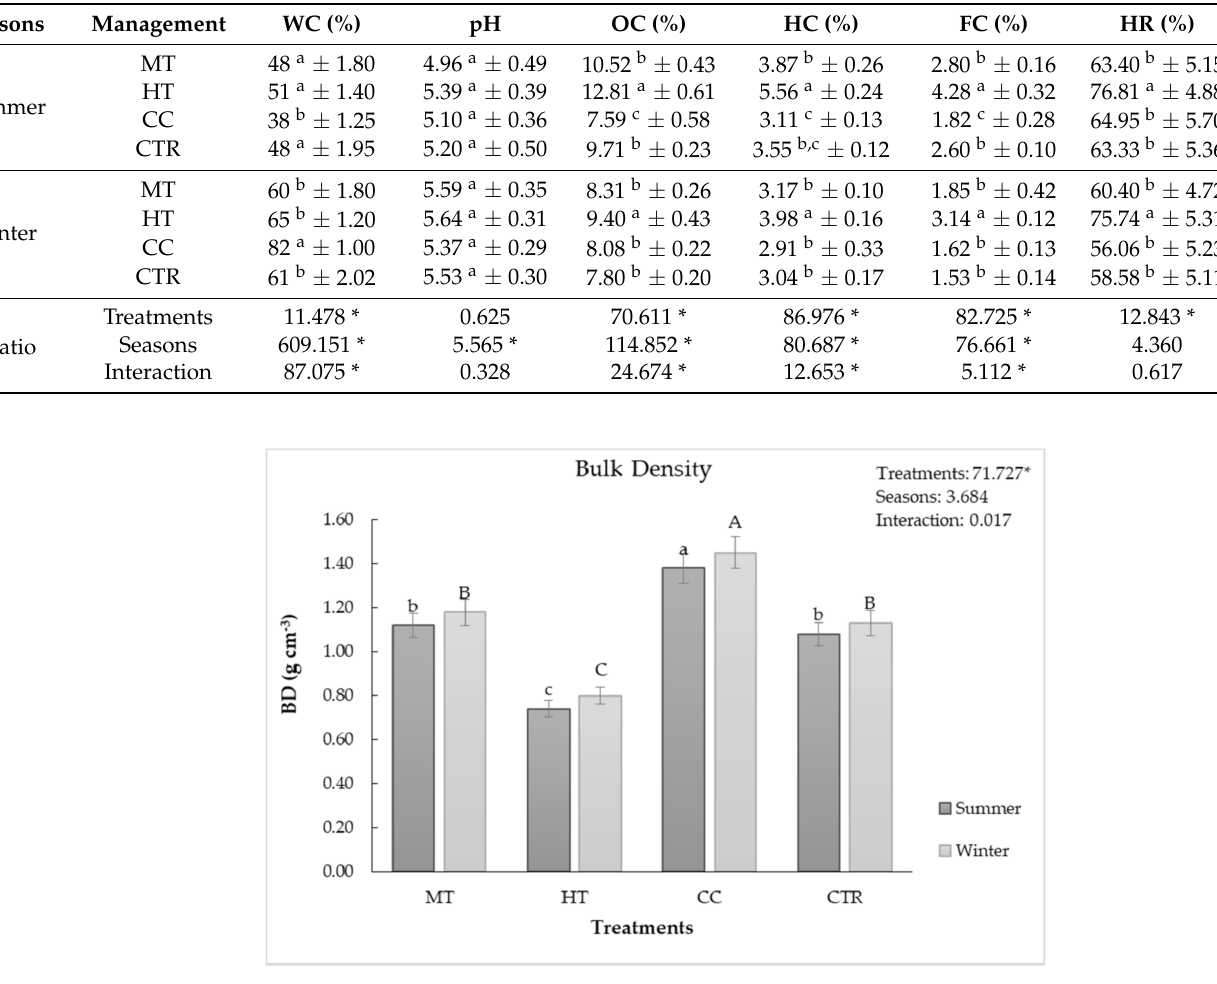
Figure 1. Bulk density (BD, g cm − 3 ) in soil under differently managed plots of a Pinus laricio plantation in summer and winter. HT: intensive thinning; MT: moderate thinning; CC: clear cut; and CTR: control. Two-way ANOVA shows the effects of treatments, seasons and their interactions. The data are the means of two consecutive years (2014 and 2015). * p < 0.05. Different letters show significant differences at p ≤